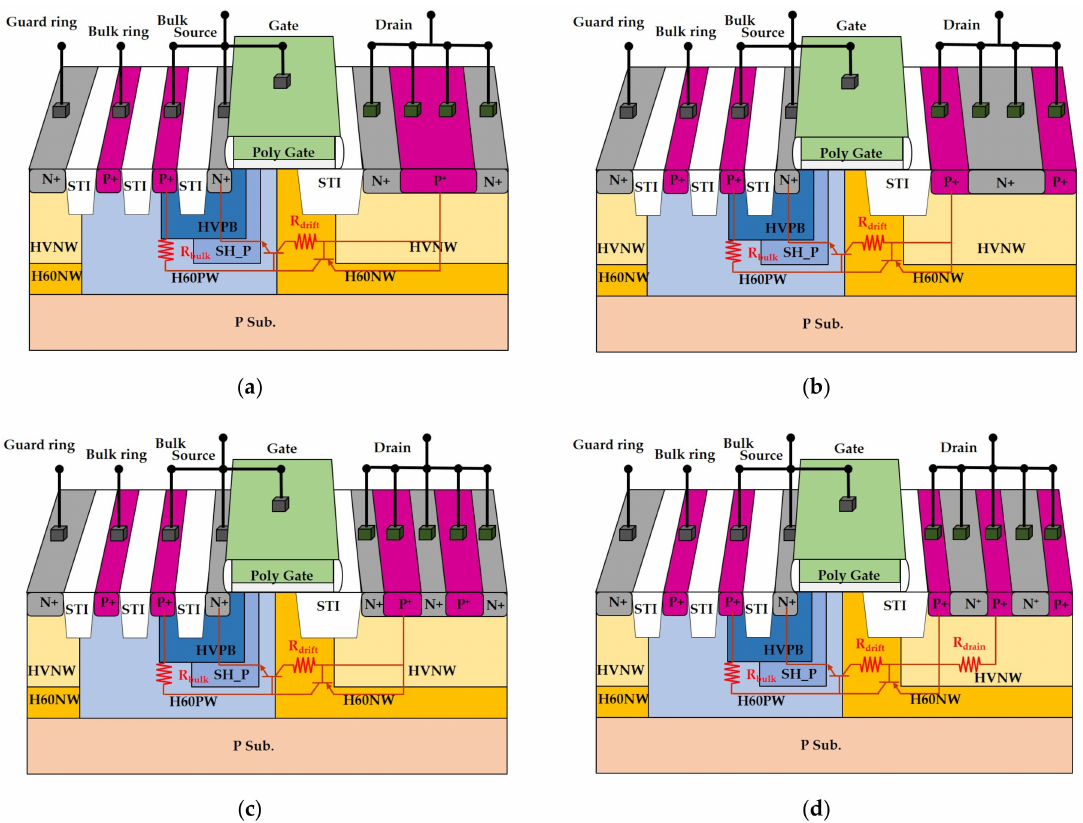
Figure 5. 3D structure views of an HV nLDMOS-SCR with drain-side; ( a ) NPN-arranged type, ( b ) PNP-arranged type; ( c ) NPNPN-arranged type; and ( d ) PNPNP-arranged